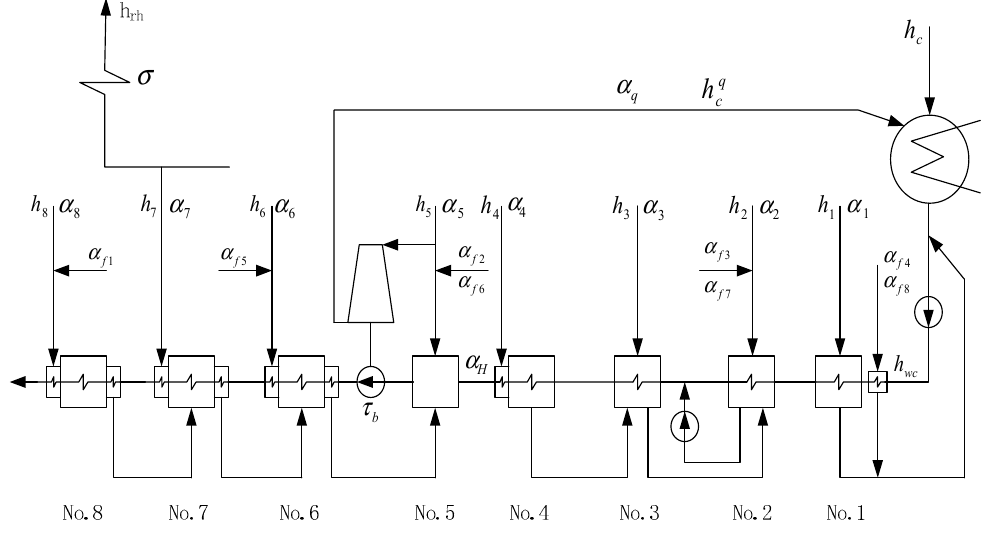
Figure 2. N300-16.5/550/550-unit thermal system. Table 2. Unit thermal parameters.